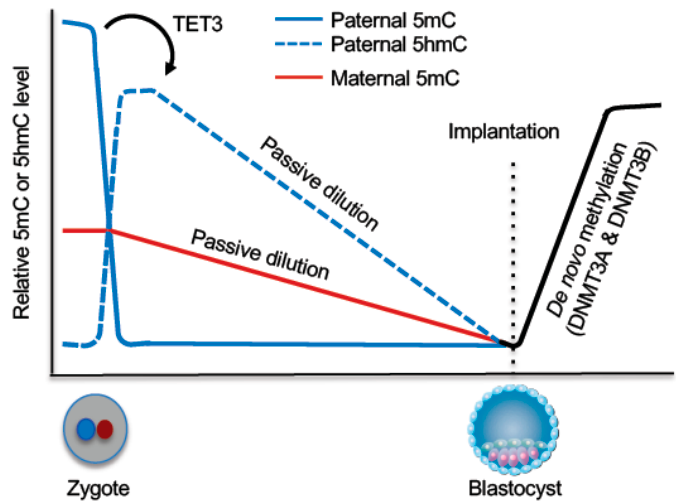
Figure 5. DNA demethylation and remethylation during early embryogenesis. Shortly after fertilization, TET3-mediated 5mC oxidation occurs in the paternal genome and the oxidized derivatives are subsequently removed through passive dilution during preimplantation development. The maternal genome mainly undergoes passive demethylation during preimplantation development. Upon implantation, a wave of de novo methylation establishes the embryonic methylation pattern.